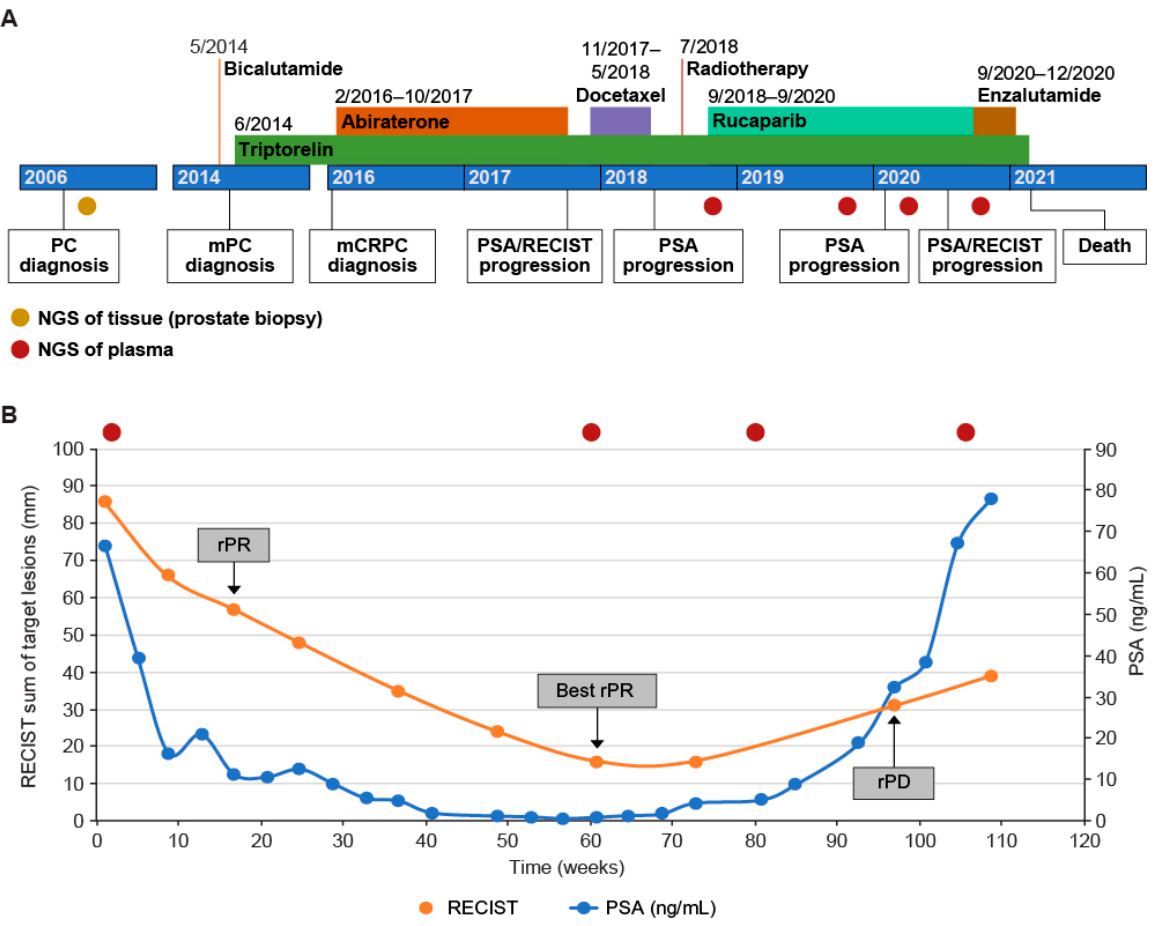
Figure 1. ( A ) The clinical course of the patient, and ( B ) the evolution of PSA and tumor measurements per RECIST with rucaparib. mCRPC, metastatic castration-resistant prostate cancer; mPC, metastatic prostate cancer; NGS, next-generation sequencing; PC, prostate cancer; PSA, prostate-specific antigen; RECIST, Response Evaluation Criteria In Solid Tumors, version 1.1; rPD, radiological progressive disease; rPR, radiological partial response.